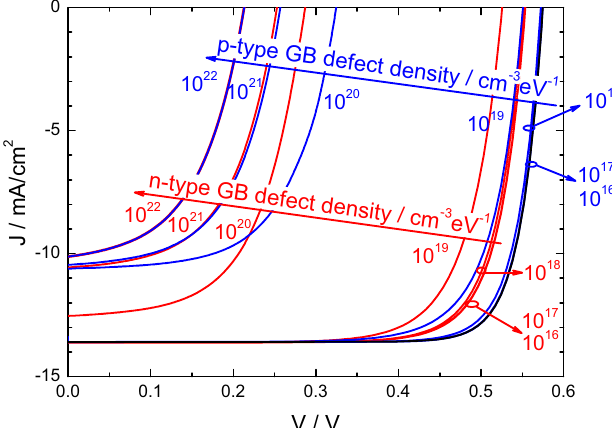
Fig. 2. Calculated J-V characteristics under illumination of the structures A (black line), B (blue lines) and C (red lines) for a highly doped GB with N A , D = 10 19 cm − 3 at varying GB defect